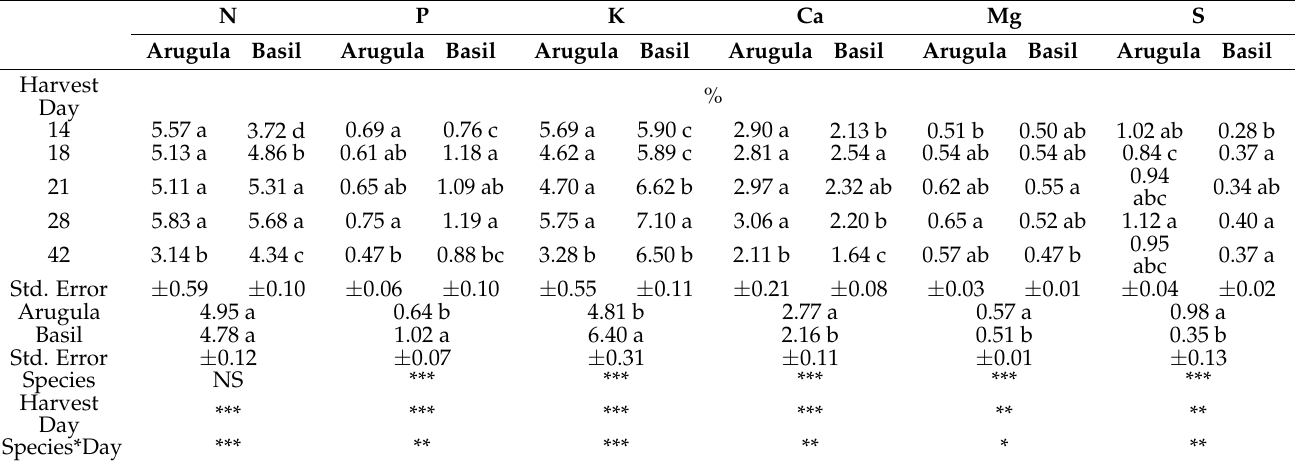
Data are least-square means of four and 20 replicates per harvest day and averaged over 42 d for each species, respectively. Means separated using Tukey’s honestly significant difference (HSD) at α = 0.05. Means followed by the same letter were determined not to be statistically different. NS, *, **, *** refer to non-significance or significance at p < 0.05, p < 0.01, and p < 0.0001,